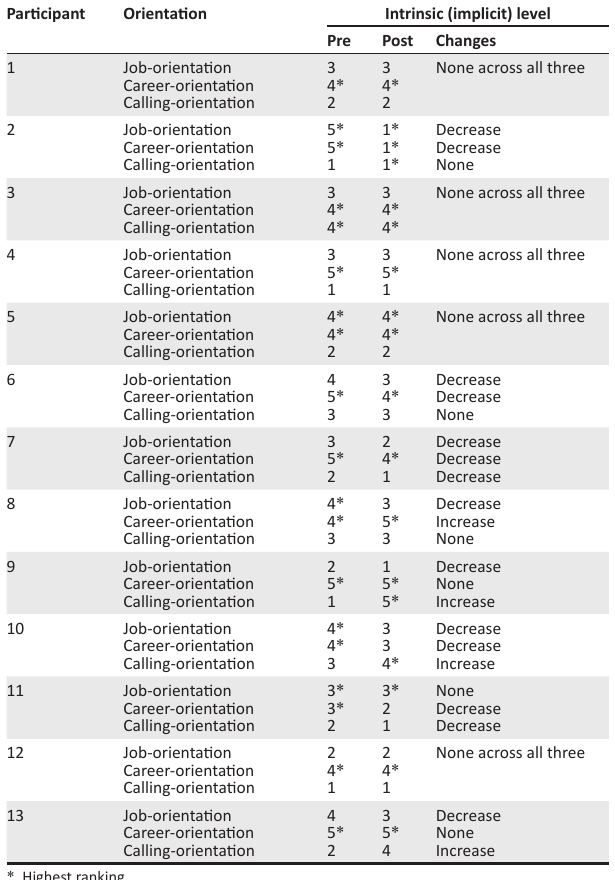
TABLE 2: Change in scores on the intrinsic (implicit)